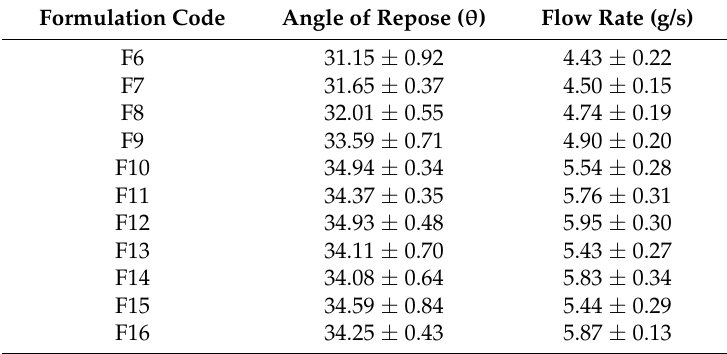
Table 2. The angle of repose and flow rate of PC-based dispersion formulations powderized with Neusilin ® US2 measured after pouring the formulations into a funnel with an orifice of an inner diameter of 10 mm. The values are mean ± SD ( n =